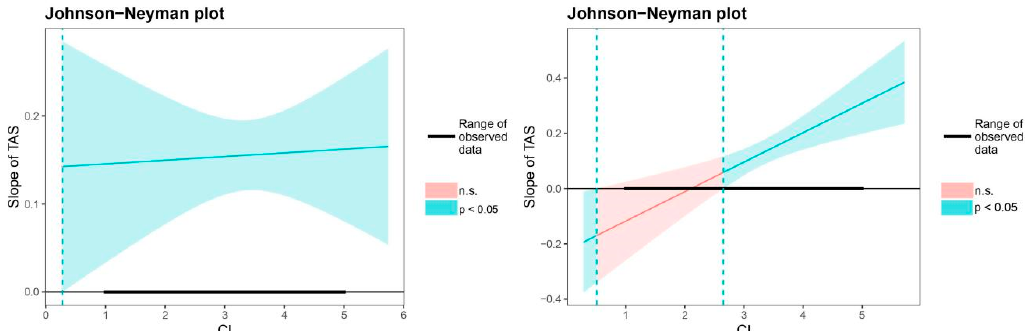
Figure 3. Johnson–Neyman regions of significance and confidence bands for the conditional relationship between teacher autonomy support and social competence as a function of consistency of interests, separately for males ( left side) and females ( right side). Note: N = 1009; TAS = teacher autonomy support; CI = consistency of interests; n.s. = non-significant.